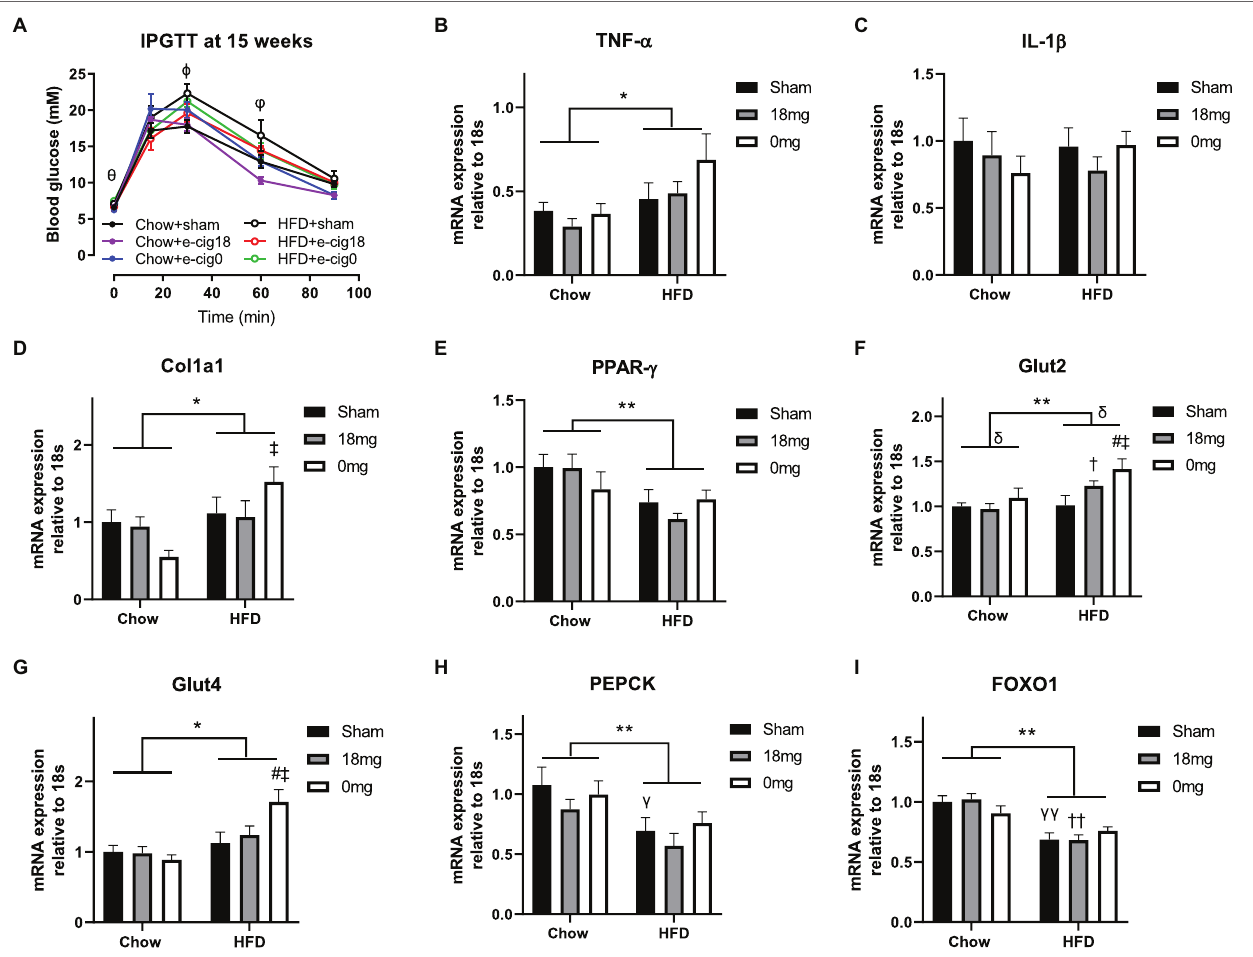
FIGURE 2 | Glucose level during intraperitoneal glucose tolerance test (IPGTT, A ) and mRNA expression of markers of inflammation [TNF- α (B) , IL-1 β (C) ], fibrosis (Col1a1, D ), insulin sensing (PPAR γ , E ), glucose transporter [Glut2 (F) , Glut4 (G) ] and gluconeogenesis [PEPCK (H) , FOXO1 (I) ] in the liver. The results are expressed as mean ± SEM, n = 5–8. Data were analysed by two-way ANOVA followed by Fisher’s least significant difference (LSD) post-hoc tests. θ p < 0.05 Chow + e-cig0 vs. HFD + e-cig0; ϕ p < 0.01 Chow + sham vs. HFD + sham; φ p < 0.05 Chow + sham vs. HFD + sham; Chow + e-cig18 vs. HFD + e-cig18; * p < 0.05, ** p < 0.01 diet effect, δ p < 0.05 e-vapour exposure effect; γ p < 0.05, γγ p < 0.01 vs. Chow + sham; and # p < 0.05 vs. HFD + Sham, † p < 0.05; †† p < 0.01 vs. Chow + e-cig18 and ‡ p < 0.05 vs. Chow + e-cig0. Col1a1, collagen 1a1; FOXO1, Forkhead box protein O1; Glut, glucose transporter; PEPCK, phosphoenolpyruvate carboxykinase; and PPAR, Peroxisome proliferator-activated